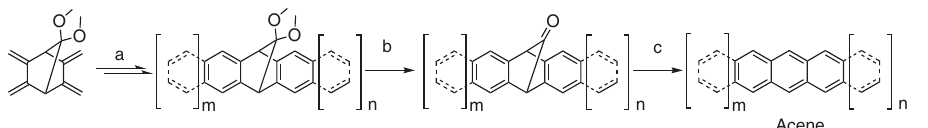
Fig. 2 Schematic strategy of the preparation of various acenes starting from 7,7 ‐ dimethoxy ‐ 2,3,5,6 ‐ tetramethylenebicyclo[2.2.1]-heptane. Diels-Alder addition ( a ) with arynes, followed by aromatization gives a non-planar bridging dimethylketal, which can be deprotected ( b ) to yield a polyaromatic